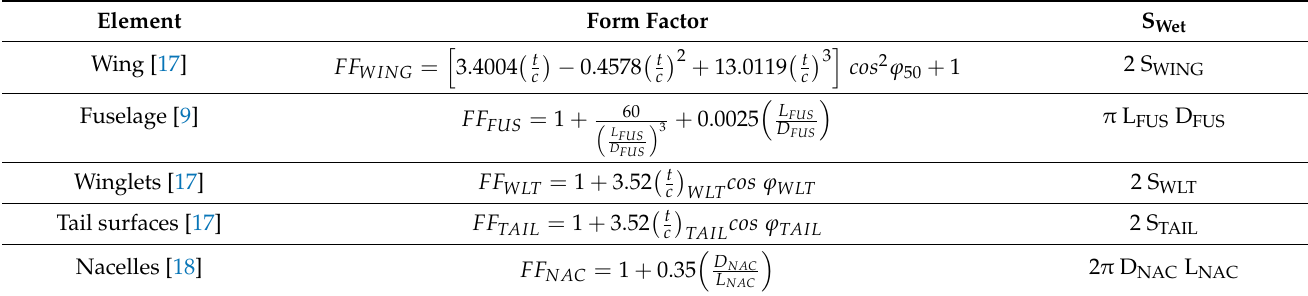
Figure 12. Estimation of Θ at airfoil trailing-edge for transitional flow.